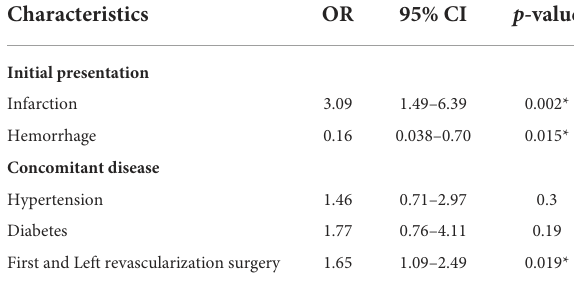
TABLE 4 Logistic regression analysis for predictive factors of postoperative